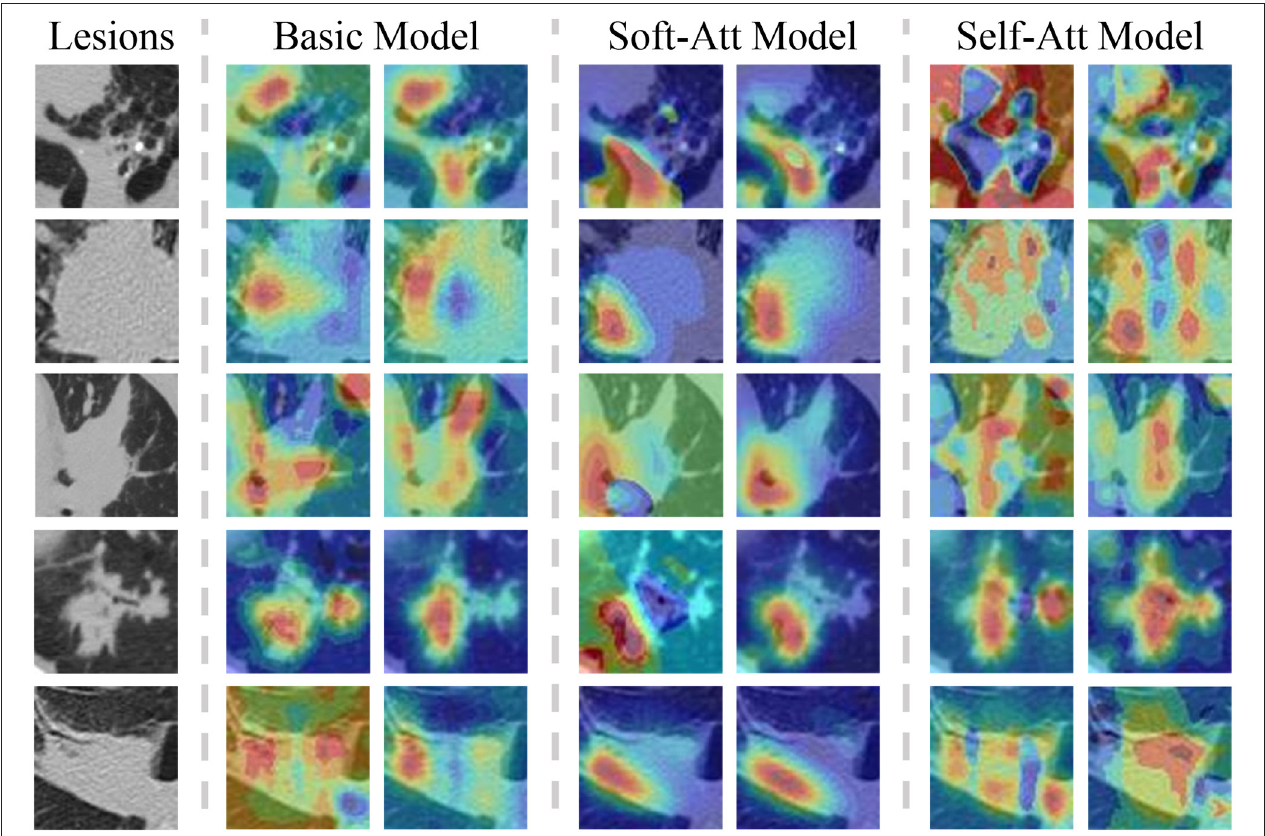
FIGURE 7 | The lesions with two heatmaps from the basic model, soft-Att, self-Att, respectively, in the lesion type and lobulation attributes. The color means the importance of the feature in that position. The red color indicates an important feature. As the figures show, the attention model focuses the features on one point and self-attention spreads the features in the spatial